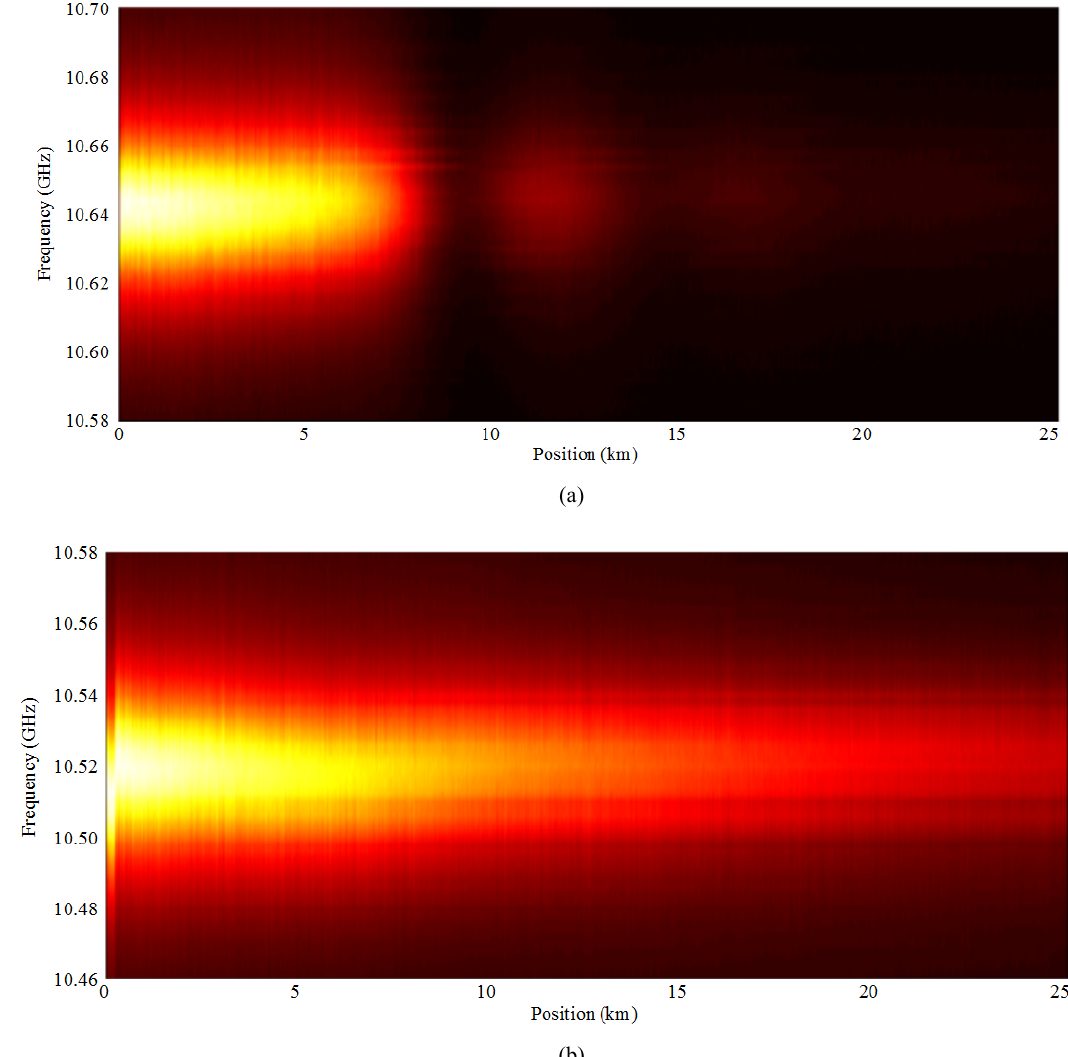
Fig. 7 Measured 3-D BGSs with a 50-ns square pump pulse at a power of 700 mW in (a) a 25-km LEAF fiber (anomalous dispersion) and (b) a 25-km MetroCor fiber (normal dispersion)